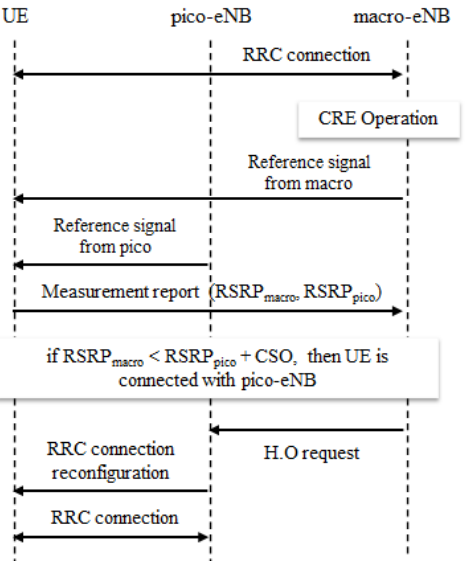
Figure 12. Cell selection procedure using CRE operation in HetNet.